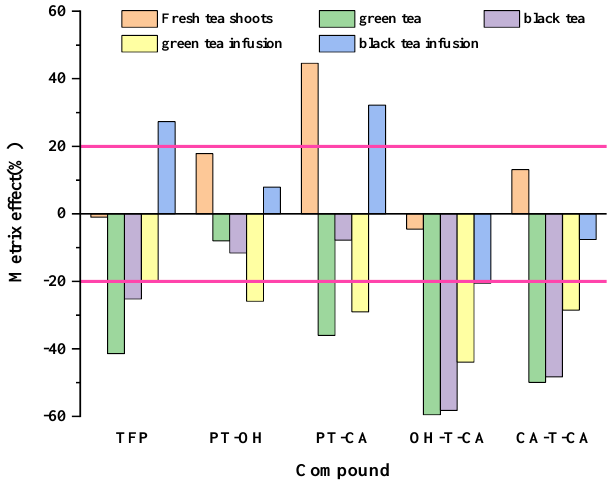
Figure 4. The matrix effect (%) of TFP and its metabolites in different tea matrix (the red horizen line represent the low matrix effect, ranging in −20% ~20%).